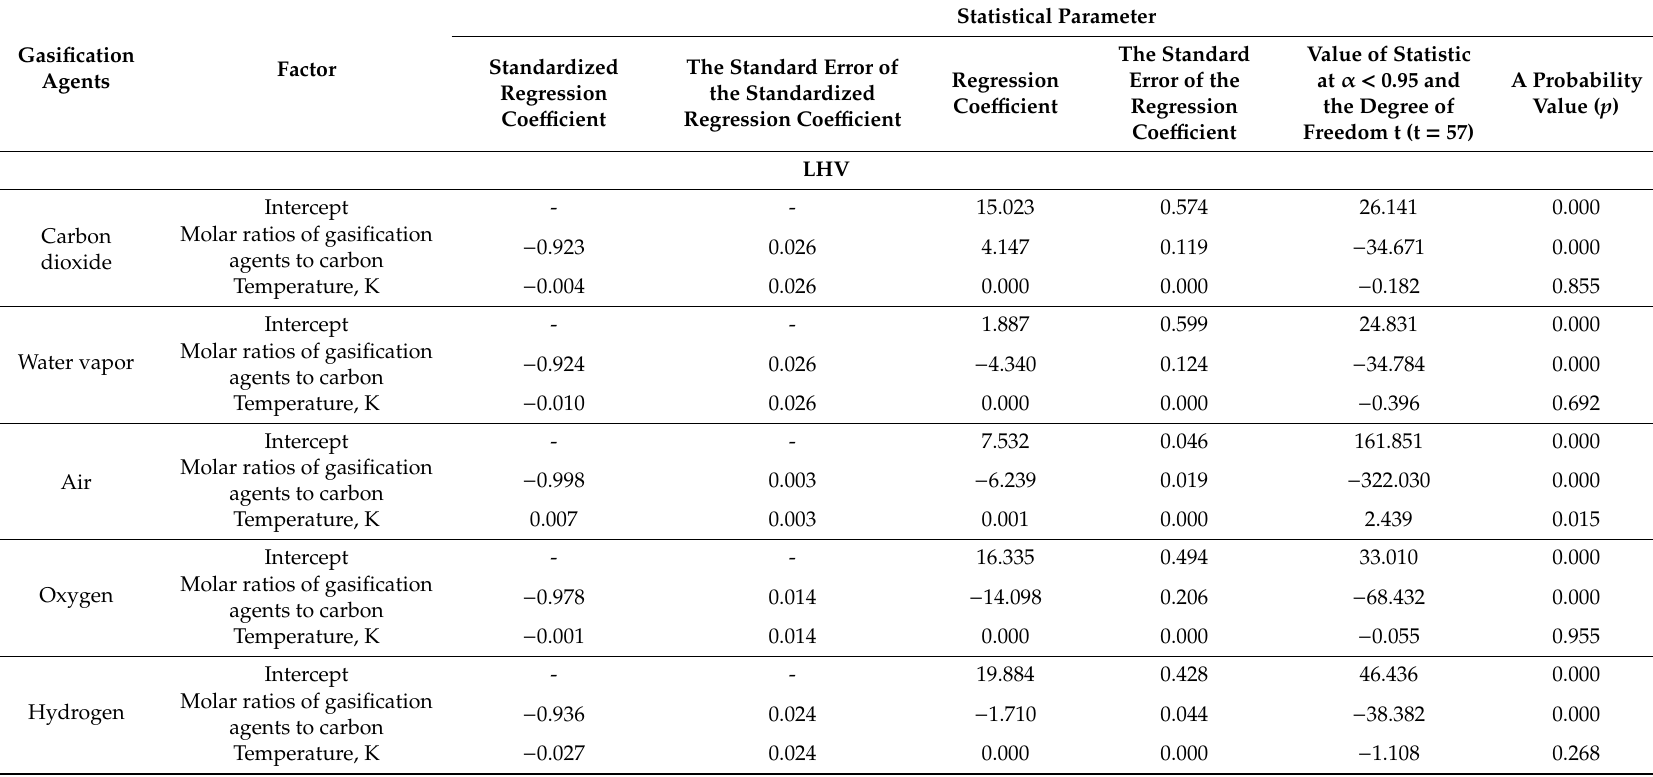
Table 5. Summary of parameterization evaluation of variables independent of the calorific value of